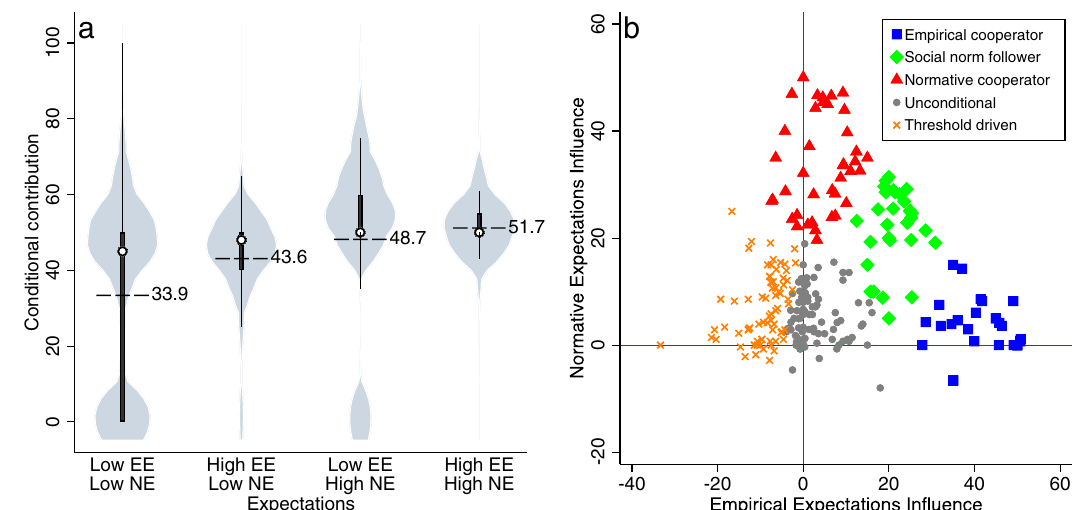
Fig. 2 Conditional contributions and behavioral types. a Conditional contribution according to empirical expectations (EE) and normative expectations (NE). High expectations imply at least 50 points and low expectations imply <50 points (e.g., the distribution for high normative expectations and low empirical expectations displays conditional contributions if the majority of one ’ s group contributes <50 and believe that you all should contribute at least 50). n = 283 individuals repeatedly measured during the experiment. Dashed lines and text values show means, hollow circle markers display medians, bars represent the interquartile range, and spikes the upper- and lower-adjacent values (see also Supplementary Fig. 1). b The horizontal and vertical lines divide the space according to subjects ’ reactions with respect to a change in, respectively, normative and empirical expectations. Along those lines the change in contribution, due to a change in the corresponding expectation, is null. n = 276 individuals. Source data are provided as a Source Data fi